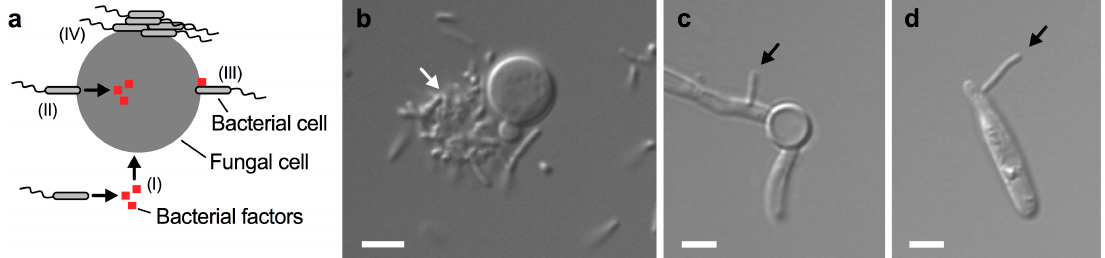
Figure 3. Close-contact interactions of B. safensis with diverse fungal pathogens. ( a ) Schematic representation of some fungal-bacterial interactions. (I) Bacteria may secrete certain factors that enter the fungal cell; (II) bacteria may attach to the fungal cell surface and inject factors into the fungus; (III) bacteria may attach to the fungal cell and express cell-surface associated factors; and (IV) bacteria may attach to the fungal cell surface and form cell aggregates and biofilms. Additional mechanisms may exist. ( b ) Di ff erential interference contrast (DIC) microscopy image of C. neoformans cells grown with B. safensis in yeast peptone dextrose medium for 24 h. Note that B. safensis appears to form a cluster of cells (indicated by a white arrow) on one side of the C. neoformans cell. ( c ) DIC microscopy image of C. albicans cells grown with B. safensis under fungal hypha-inducing conditions for 4 h. A bacterial cell (black arrow) can be seen attached to the fungal filament. ( d ) DIC microscopy image of U. maydis cells grown with B. safensis in potato dextrose broth for 24 h. A bacterial cell (black arrow) has attached to the fungal cell. Scale bars, 2 µm.